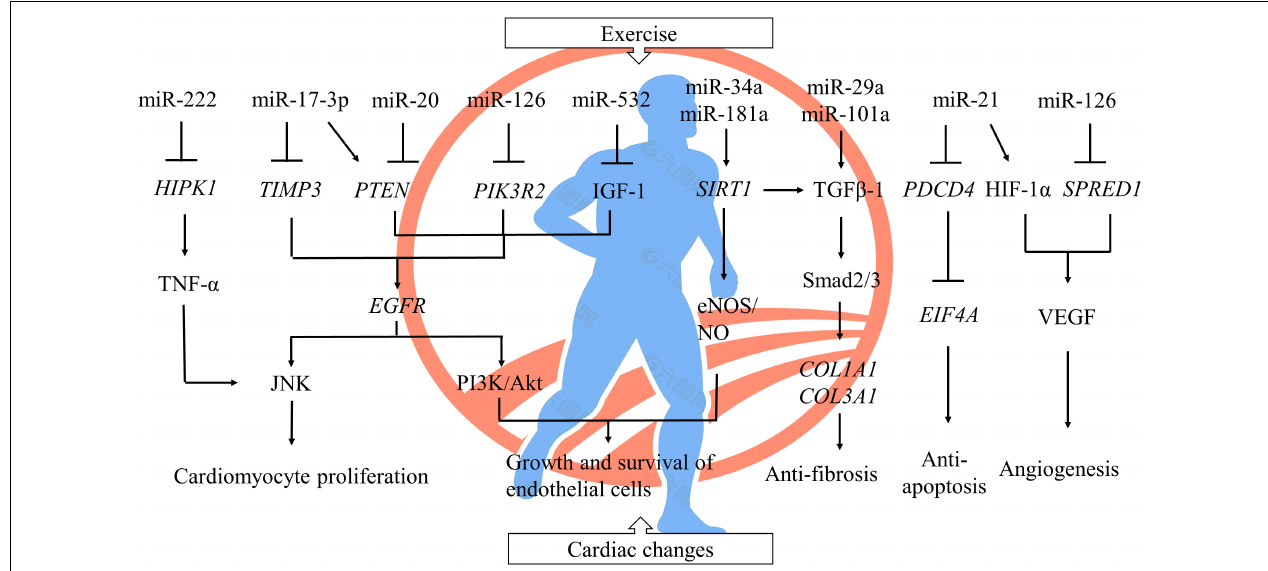
FIGURE 1 | The regulation of miRNAs to cardiac changes after exercise. A single miRNA could have thousands of target genes, and one and the same gene could also be conducted by a host of miRNAs. Exercise-induced cardiac protection involves a series of complex regulation between miRNAs and their signal pathways by inhibiting protein translation and targeting mRNA degradation. ⊥ inhibited; Gene symbols were italicized. HIPK1, homeodomain-interacting protein kinase 1; TNF- α , tumor necrosis factor α ; TIMP3 , metallopeptidase inhibitor 3; PTEN , phosphatase and tensin homolog; PIK3R2 , phosphoinositide-3-kinase regulatory subunit 2; IGF-1, insulin-like growth factor 1; EGFR , epidermal growth factor receptor; JNK, c-Jun N-terminal kinase; PI3K, phosphoinositide 3-kinase; SIRT1 , sirtuin-1; NO, nitric oxide; eNOS, endothelial nitric oxide synthase; TGF β -1, transforming growth factor β 1; COL1A1 , collagen type I alpha 1 chain; COL3A1 , collagen type III alpha 1 chain; PDCD4 , programmed cell death protein 4; EIF4A , eukaryotic translation initiation factor 4A; HIF-1 α , hypoxia inducible factor-1; SPRED1, sprouty-related protein 1; VEGF, vascular endothelial growth